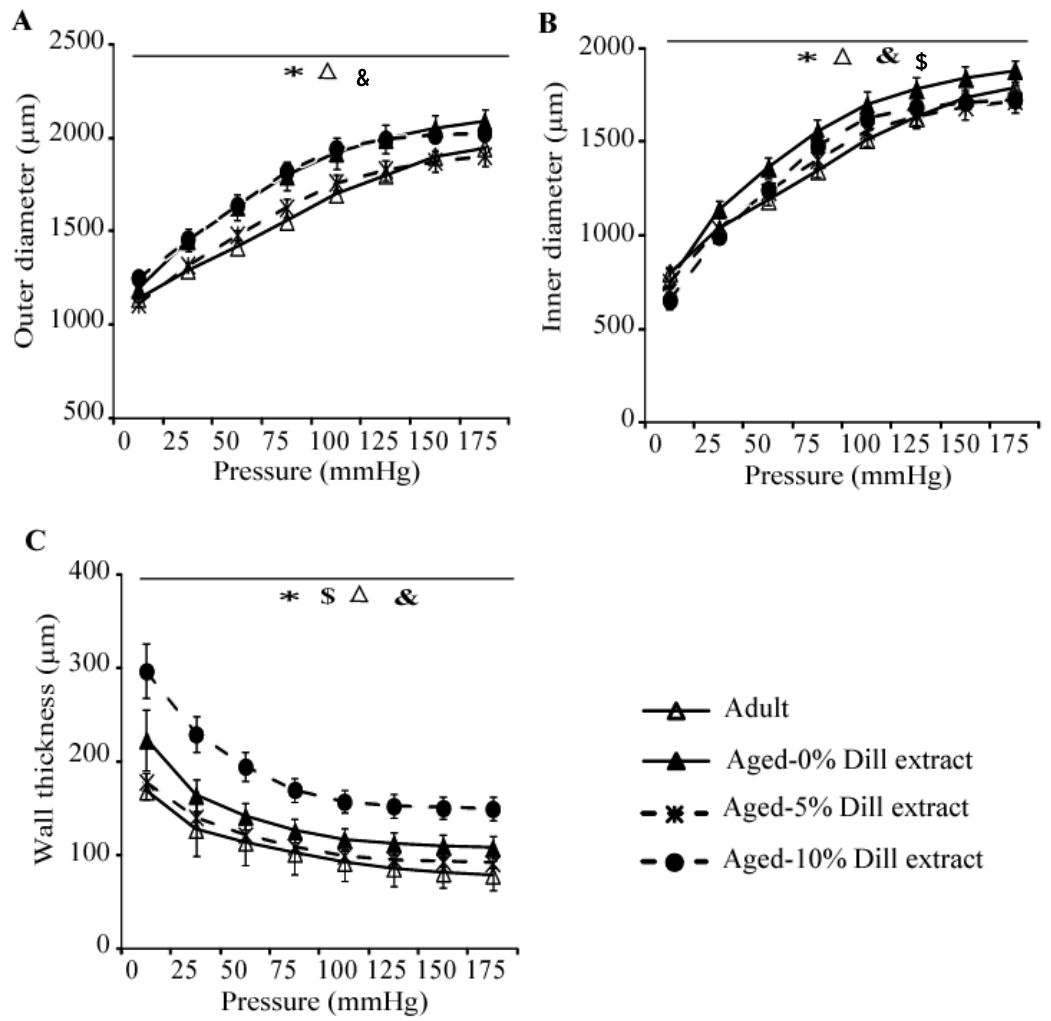
Figure 4 . Diameter-pressure curves and wall thickness of the ascending aorta of untreated, 5% DE- or 10% DE-treated aged mice, as well as untreated (control) adult animals. ( A ) Outer diameter-pressure relation; ( B ) inner diameter-pressure relation; ( C ) wall thickness-pressure relation. * General significant difference between untreated adult and untreated aged mice (two-way ANOVA, p ≤ 0.05). & General significant difference between 10% DE-treated aged mice and untreated adult mice (two-way ANOVA, p ≤ 0.05). $ General significant difference between 10% DE-treated and untreated aged mice (two-way ANOVA, p ≤ 0.05). Δ General significant difference between 5% DE-treated and untreated aged mice (two-way ANOVA, p ≤ 0.05). n = 4–7 per group.